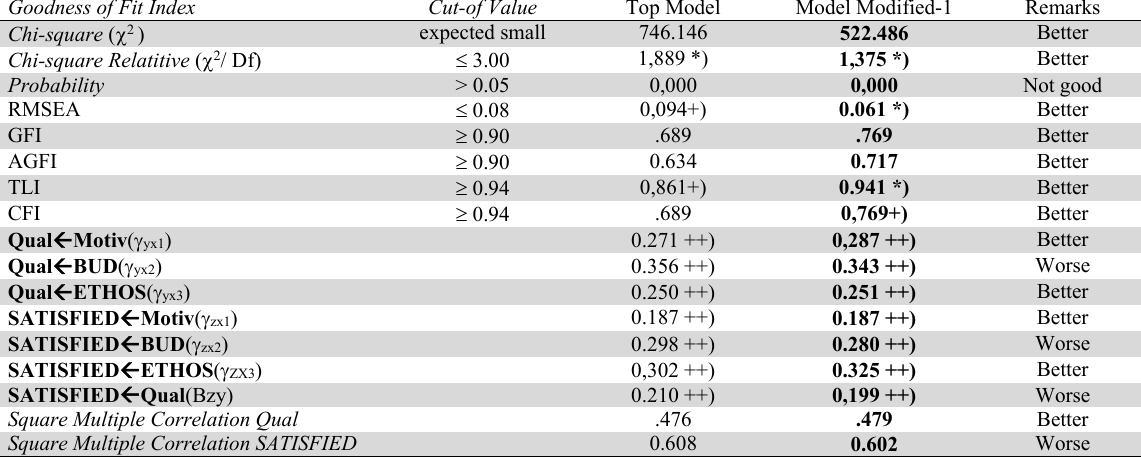
Top Model Comparison with the